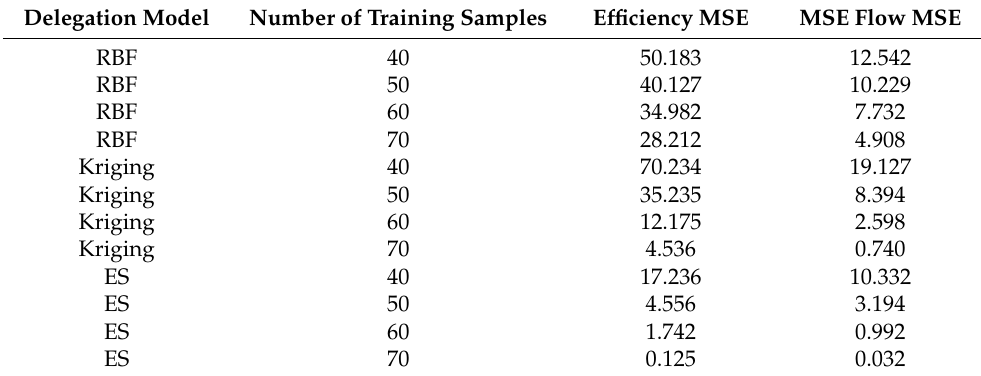
Table 1. Comparison of sample size and output response MSE for different surrogate